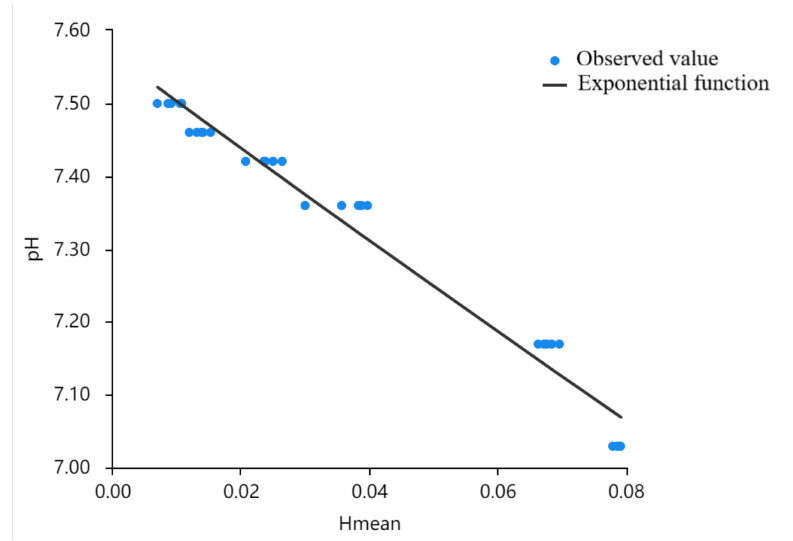
Figure 8. Fitting diagram of H-Mean and pH cubic